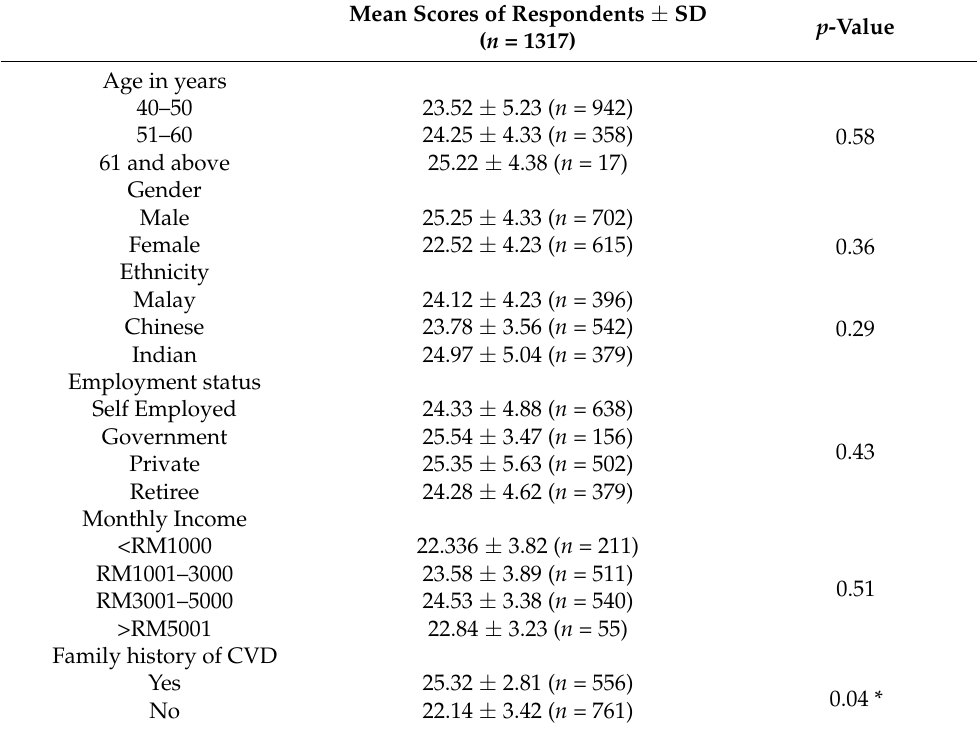
Table 2. One-way analysis of variance and t -test followed by Tukey’s post hoc test.